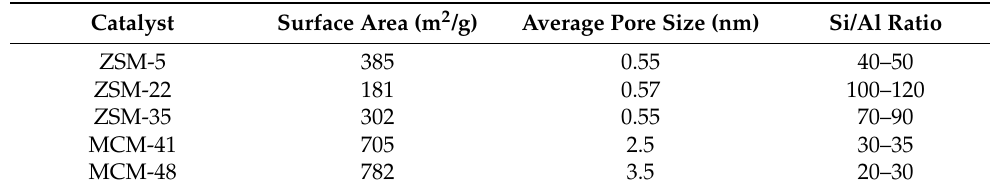
Table 4. Physical properties of heterogeneous